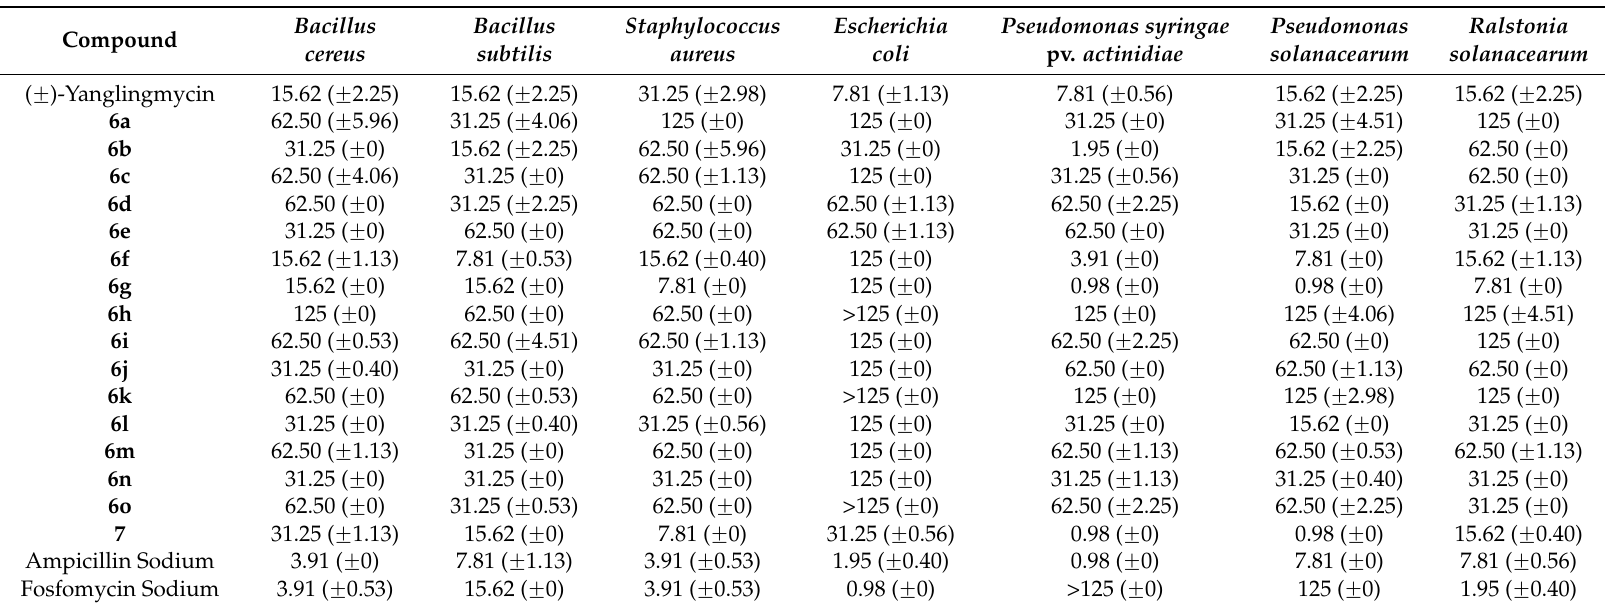
Table 2. The MICs of ( ˘ )-Yanglingmycin and its